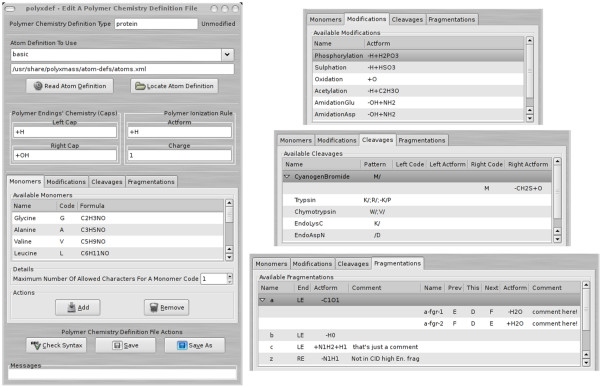
Polymer chemistry definitions in the polyxdef module. The elaboration of polymer chemistry definitions is shown in this figure. The definition window is shown on the left, and the screen dumps on the right correspond to the three tabs that are hidden on the left representation of the window. The editing of items in the treeviews is straighforward and takes place in the item rows directly. The example shown pertains to the "protein" polymer chemistry definition. See text for details.